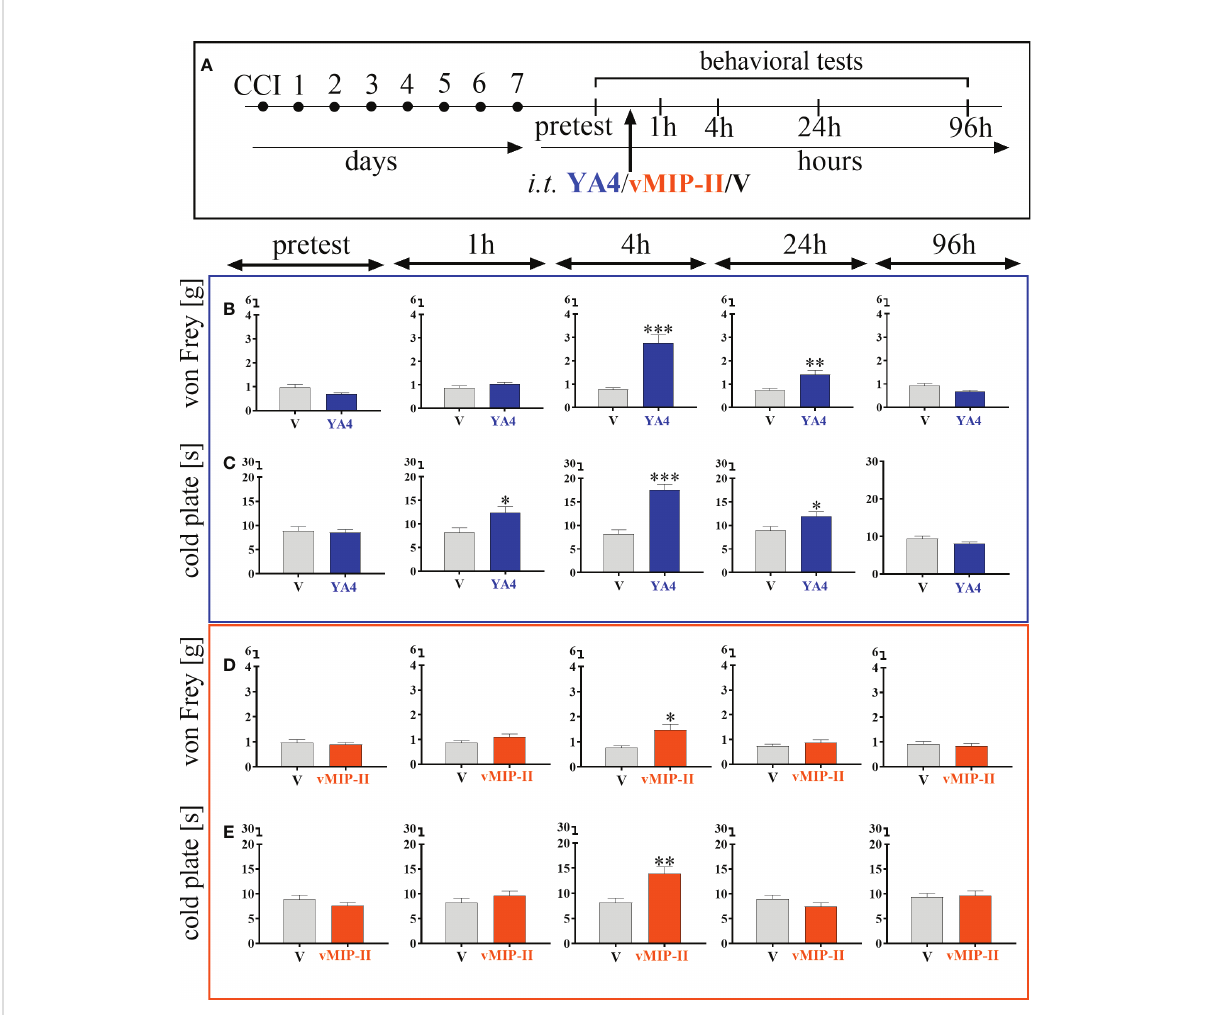
FIGURE 6 The in fl uence of ITGA9 neutralization by YA4 (B, C) or XCR1 blockade by vMIP-II (D, E) , administered according to scheme (A) , at a dose of 1 m g/5 m l on mechanical (B, D) and thermal (C, E) hypersensitivity 7 days after chronic constriction injury (CCI) of the sciatic nerve in mice. Data are presented as the mean ± SEM (n =5 – 8). The results were evaluated using t tests for comparisons of selected pairs; ✽ p<0.05; ✽✽ p<0.01; ✽✽✽ p<0.001 indicate signi fi cant differences between the V – vs. YA4 – /vMIP-II – treated groups. “ V ”– vehicle